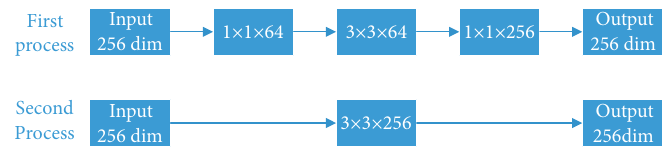
Figure 4: Comparison of the convolution process with and without 1 × 1